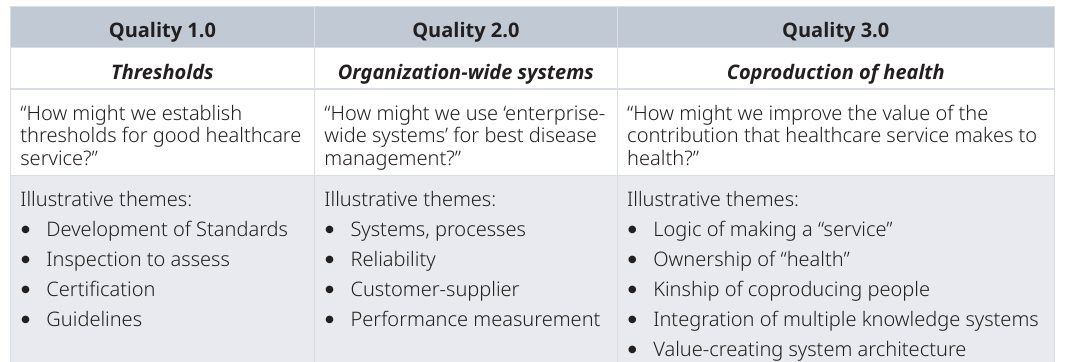
Table 1. Stages of quality improvement in